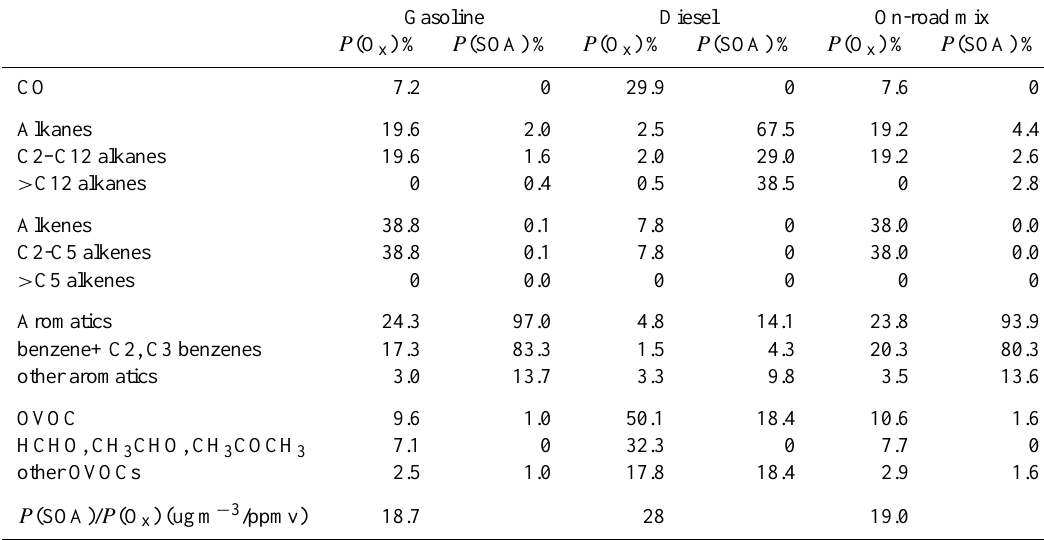
Table 1. Summary of the relative contribution of various VOC classes to O x and SOA production from gasoline and diesel exhaust. The on-road fuel mix is defined as 22% diesel and 78% gasoline by volume. The “benzene + C2, C3 benzenes” category includes benzene, toluene, ethyl benzene, xylenes, propyl benzenes, trimethyl benzenes, and ethyl toluenes. SOA yields are based on an M o value of 5µg/m 3 . UCM not included.